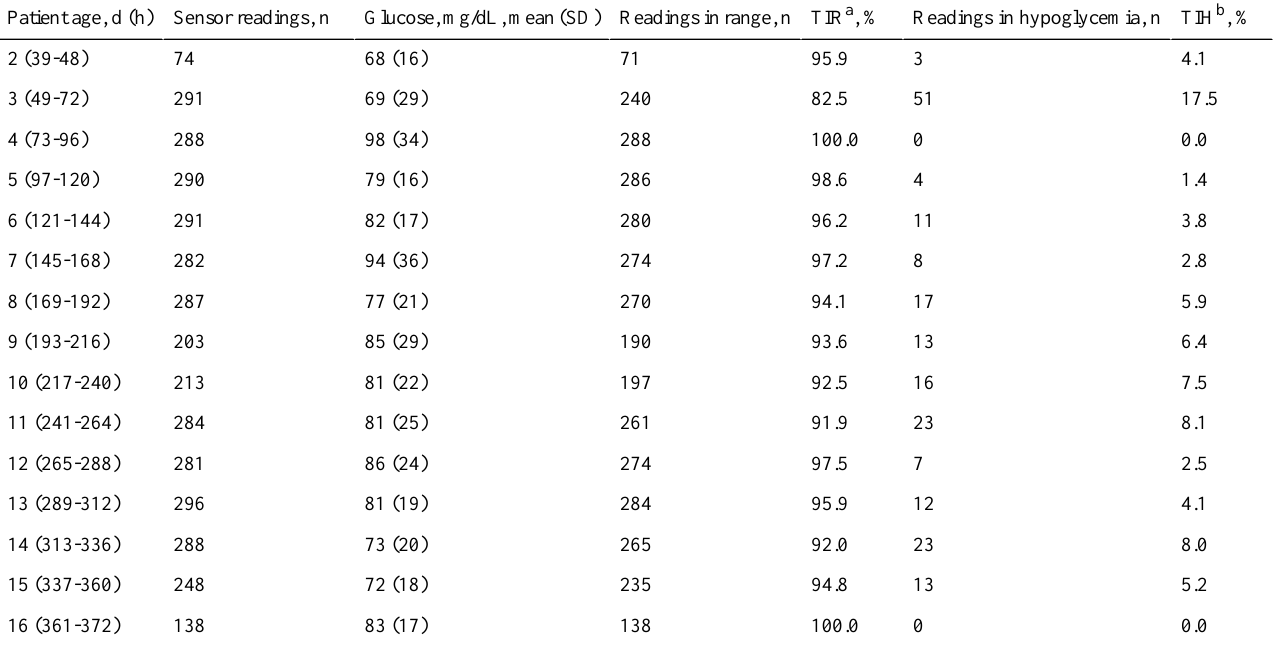
Table 1. Analysis of rtCGM readings within the first 16 days of life in a neonate with transient CHI, including mean sensor glucose (SD), time in hypoglycemia (defined as the percentage of sensor readings below 45 mg/dL), and time in range (defined as the percentage of sensor readings between 45 mg/dL and 180